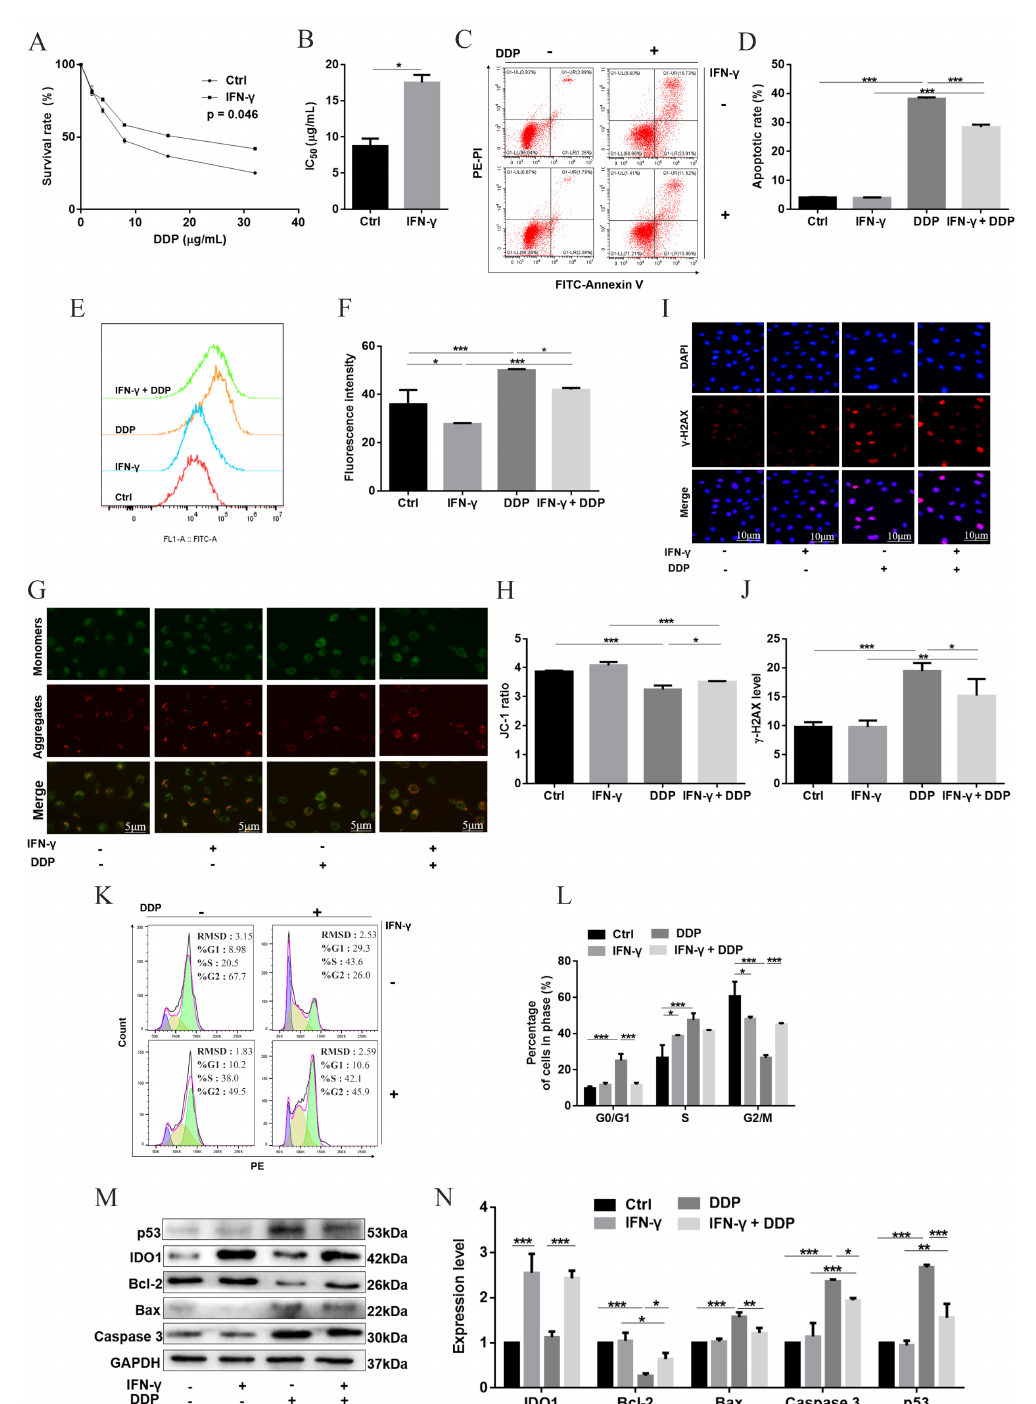
Figure 2. The effect of IDO1 on DDP-induced apoptosis in SKOV3 cells. ( A , B ) Cell-survival percentages and IC 50 of DDP. ( C , D ) Apoptotic cells were detected by the Annexin V assay. ( E , F ) ROS generation was detected by flow cytometry. Data were expressed as mean fluorescence intensity. ( G , H ) MMP determined with the JC-1 assay; representative images of J-aggregates (red) and monomer (green); the scale bar was 5 µ m; JC-1 ratio reflected MMP. ( I , J ) γ -H2AX was detected using immunofluorescence (red), cells were counterstained with DAPI to visualize nuclei (blue); representative images; the scale bar was 10 µ m; the fluorescence intensity indicated the γ -H2AX level. ( K , L ) Cell cycle analyzed by flow cytometry. ( M , N ) Apoptosis-related proteins assayed by western blot. Data were mean standard deviation for three independent trials. *: p < 0.05; **: p < 0.01; ***: p < 0.001. ±